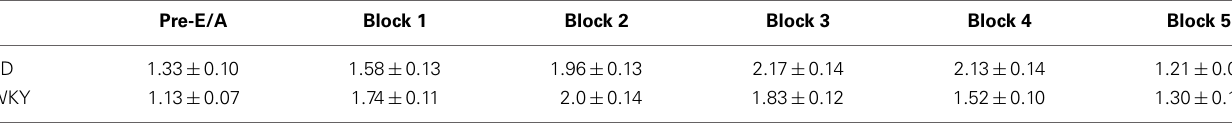
Table 1 | The effect of avoidance acquisition on the estrous cycle over the 5 session blocks of the training.